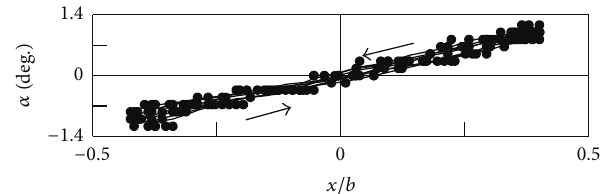
Figure 15: The angle of the body tilt variation during the